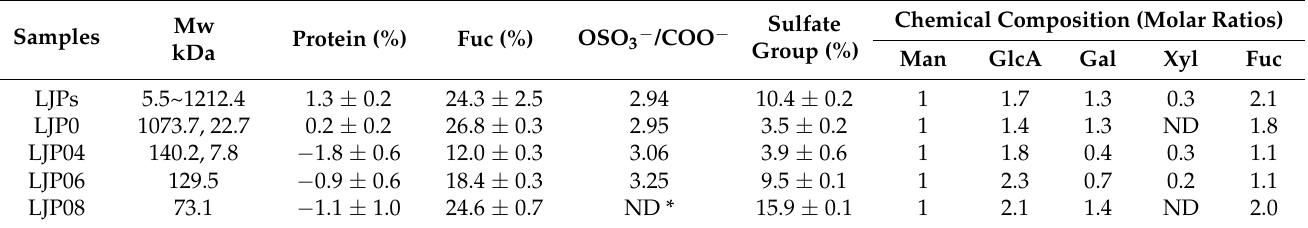
Table 1. Chemical compositions and physicochemical properties of LJPs and the purified fractions.